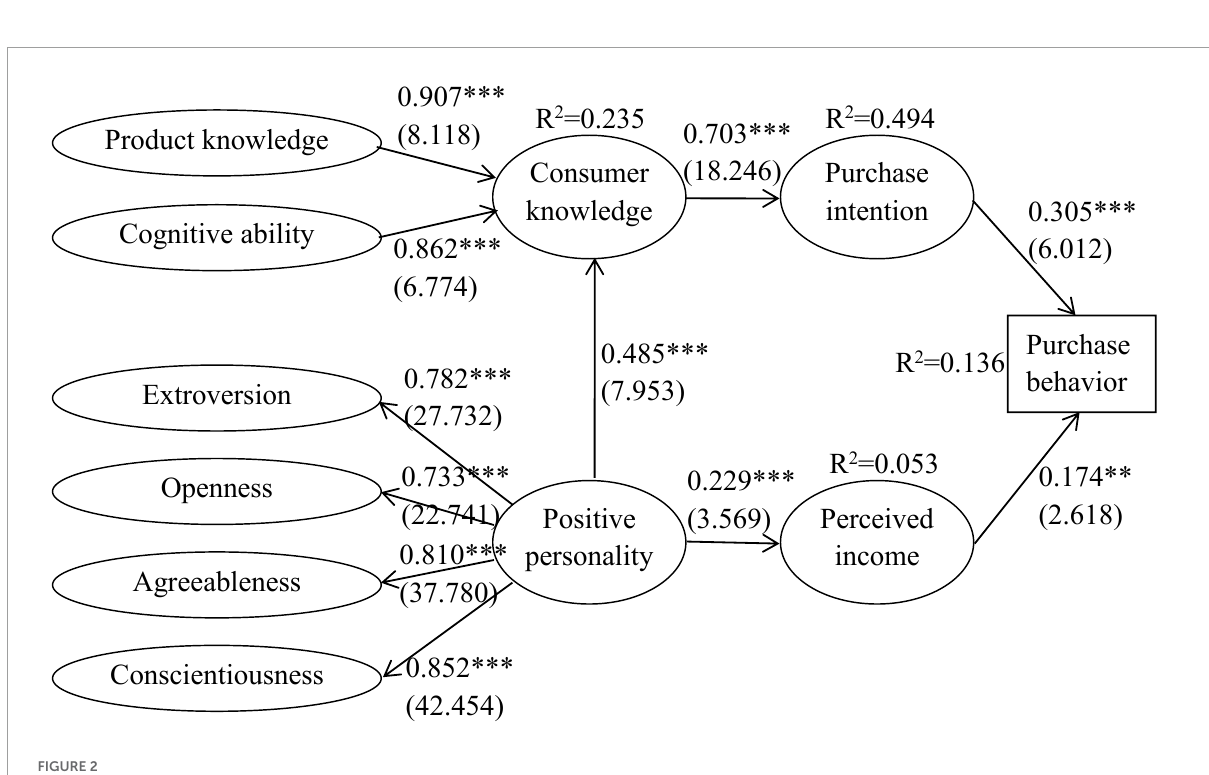
FIGURE2 Estimation results of PLS-SEM. ∗∗∗ p < 0.001, ∗∗ p < 0.01. The data inside the parentheses are t